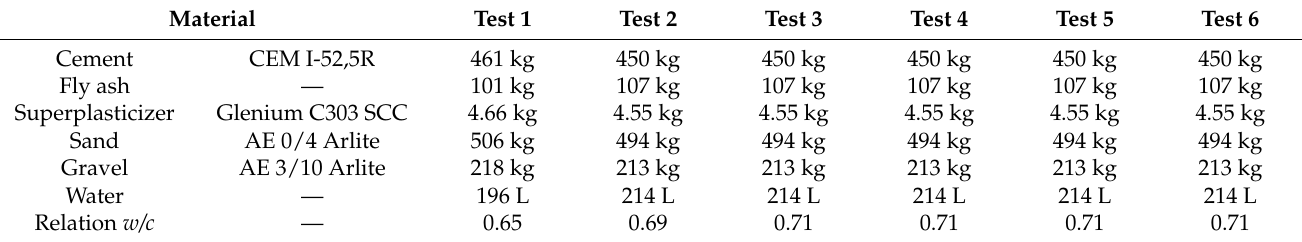
Table 12. Formulation of insulating refractory concrete for lab